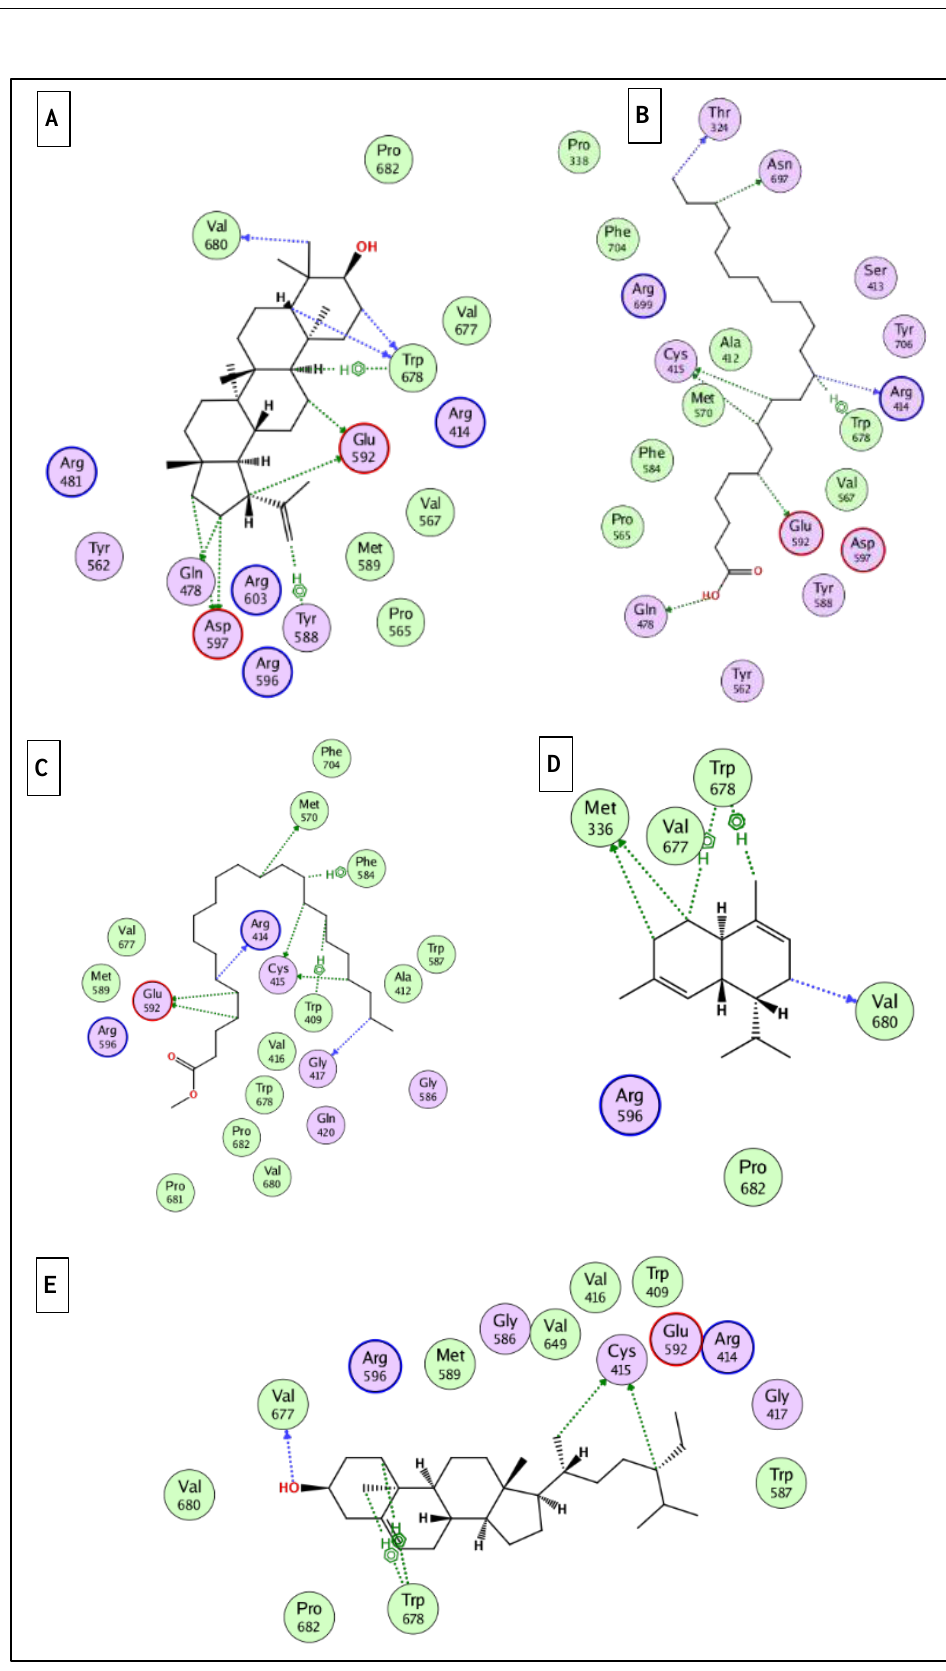
Figure 9. 2D binding modes of ( A ), n- docosanoic acid ( B ), methyl tricosanoate ( C ), α -muurolene ( D ), and gamma-sitosterol ( E ) to the active binding sites of nitric oxide synthase (iNOS).